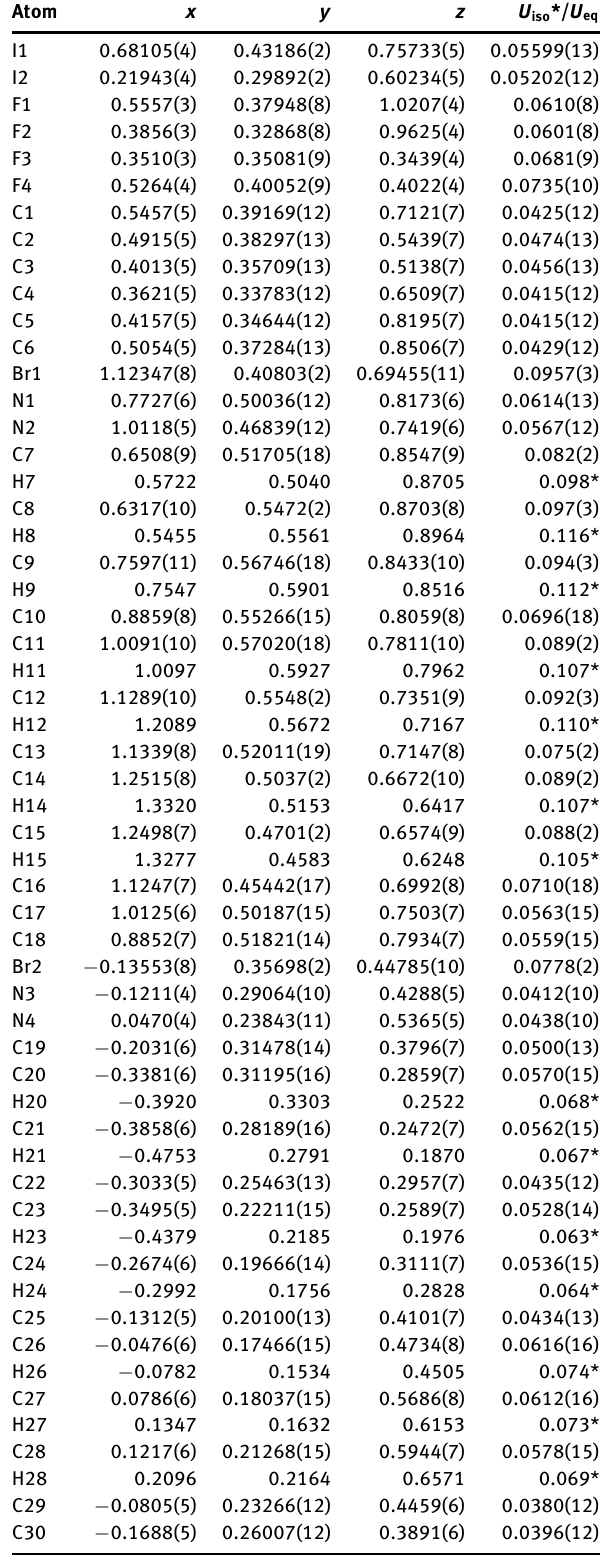
Table 2: Fractional atomic coordinates and isotropic or equivalent isotropic displacement parameters (Å 2